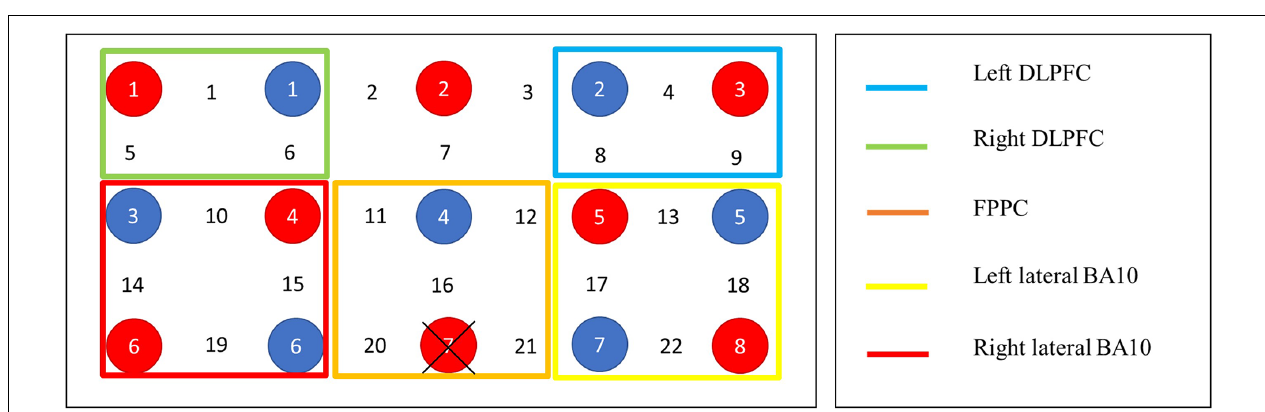
FIGURE 2 | Schematic illustration of the procedural flow for experiment 1.